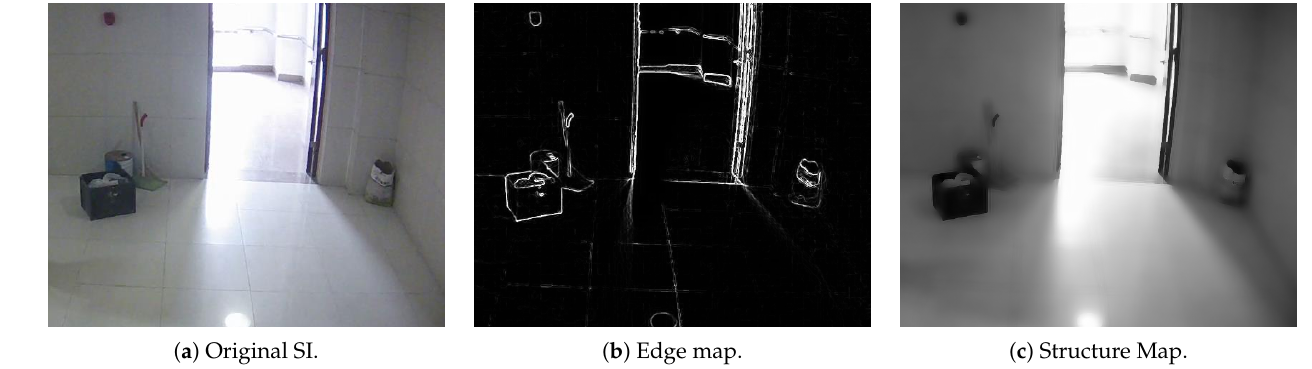
Figure 5. Exhibition of piecewise smooth image